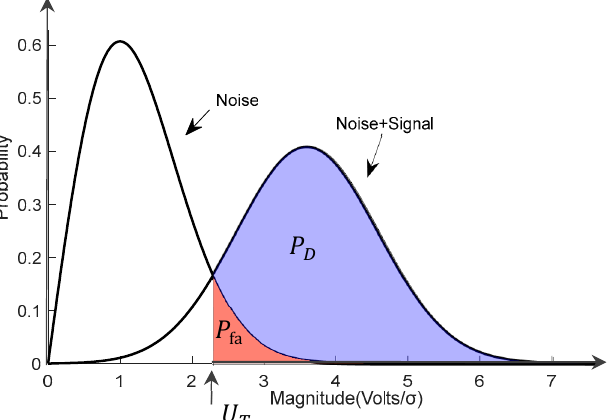
Figure 1. This is the probability density of a filter output for a representative signal-to-noise ratio. The area under the curve to the right of U T is the probability of detection, P D . Note that while increasing U T decreases P fa , it also decreases P D .